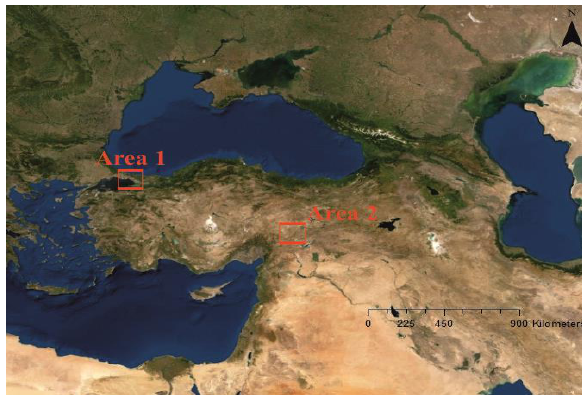
Figure 1. Study Areas on Turkey Satellite Image Istanbul is the most populous city in Turkey, it has the traffic jams and dense residential area. For this reason, urban areas of Istanbul are constantly being monitored. Area-2 was designated